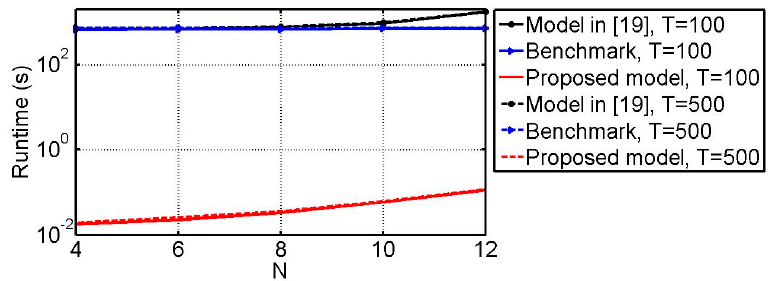
Figure 12. Runtime versus N .